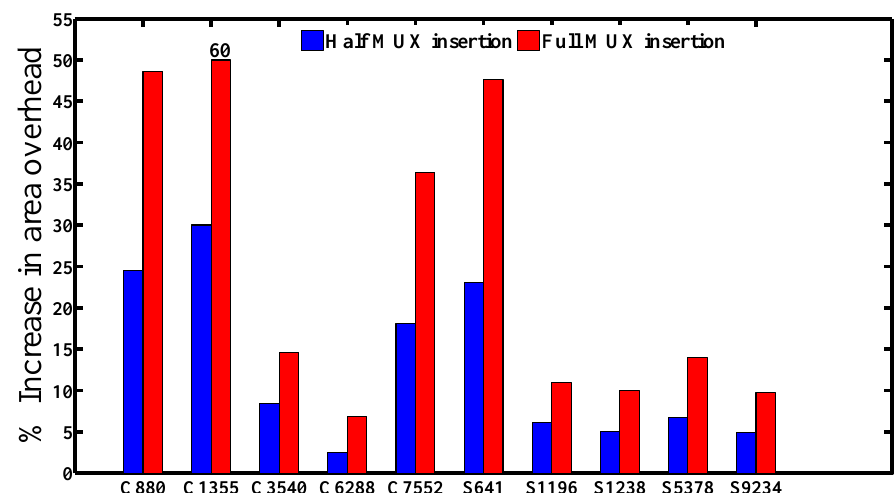
Figure 12. Comparing the area overhead of full and half MUX insertions for logic